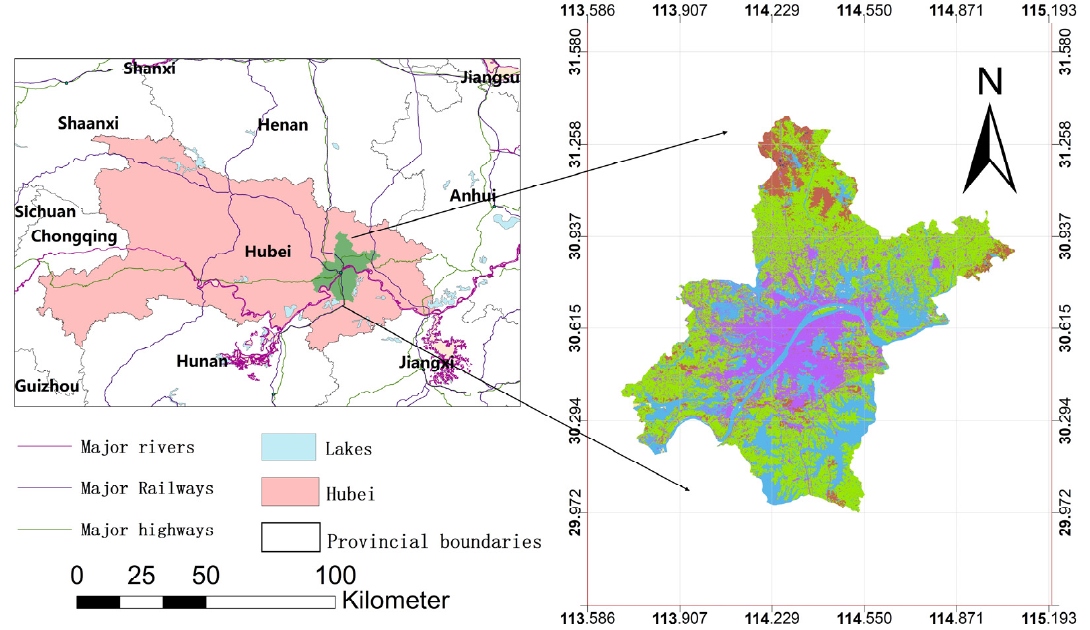
Figure 1. Wuhan city location map. ( a ) Location of Wuhan; ( b ) longitude and latitude of Wuhan.